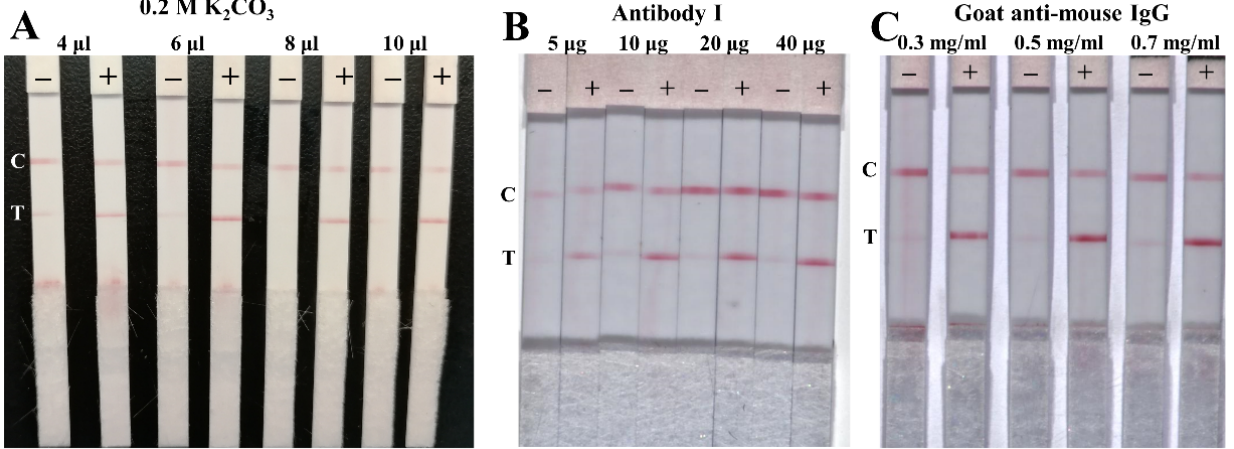
Figure 3. Optimization of the amount of 0.2 M K 2 CO 3 solution used ( A ), antibody I used in the detection probes ( B ), and goat anti-mouse IgG on the control line ( C ). The positive sample was buffer spiked with 0.1 µ g/mL of the NP antigen.